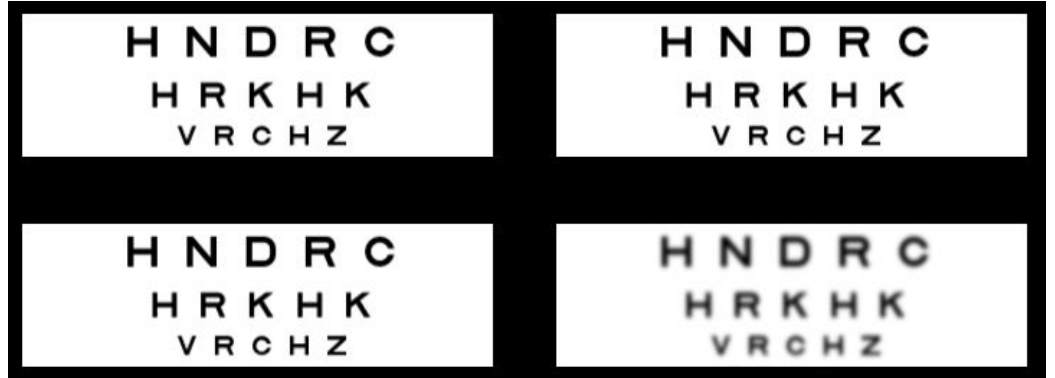
Figure 2. Tolerance to blur visual target, with the blurred target in the bottom right hand quadrant in this